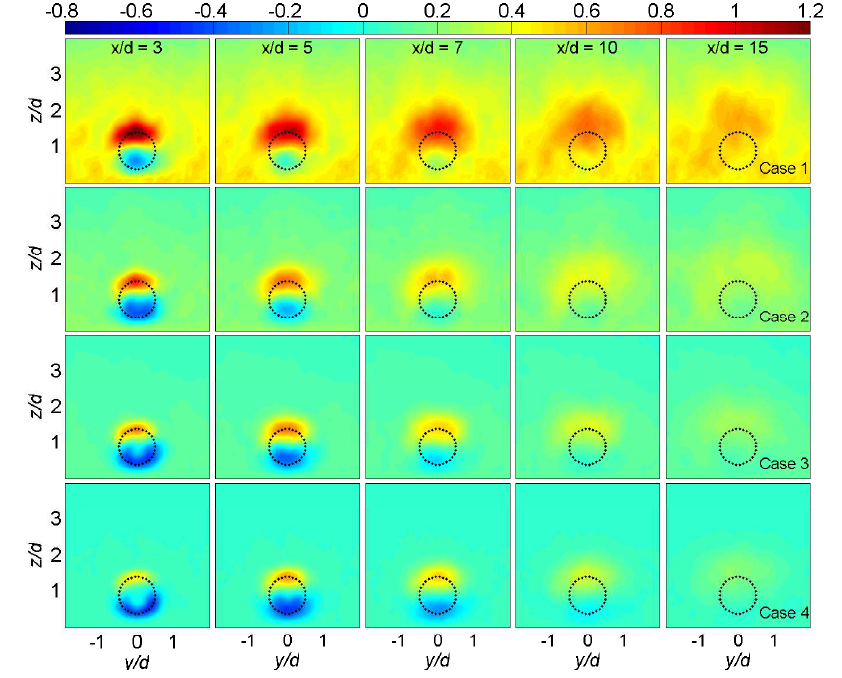
(m 2 s − 2 ) at the lateral cross-sectional xz